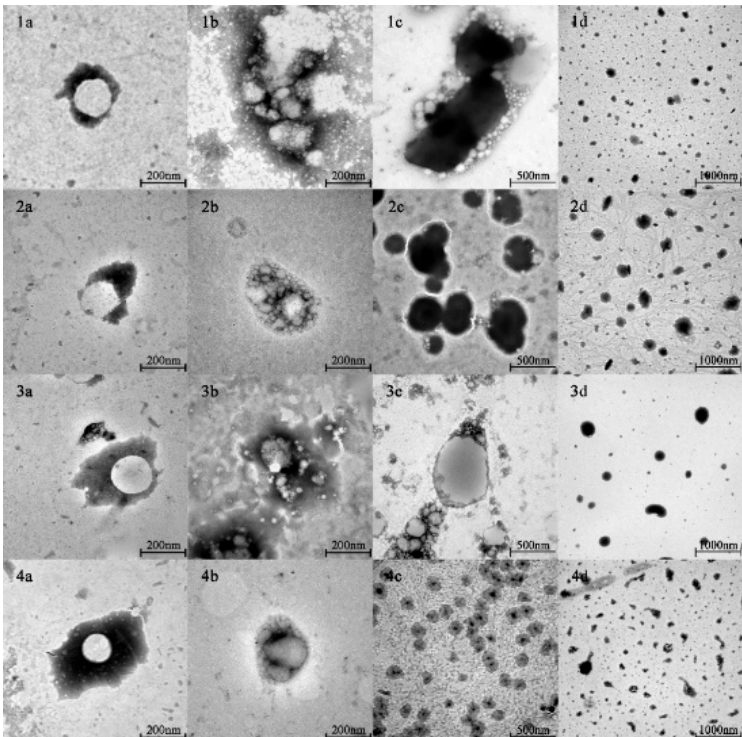
Figure 1. The nanostructures of PPI-, SPI-, RBPI-, and WPI-stabilized nanoemulsions in different digestion phases. ( 1 – 4 ) show the nanostructures of PPI-, SPI-, RBPI-, and WPI-stabilized nanoemulsions, respectively. ( a – d ) show the nanostructures of nanoemulsions in initial, oral, gastric, and small intestine phases, respectively.